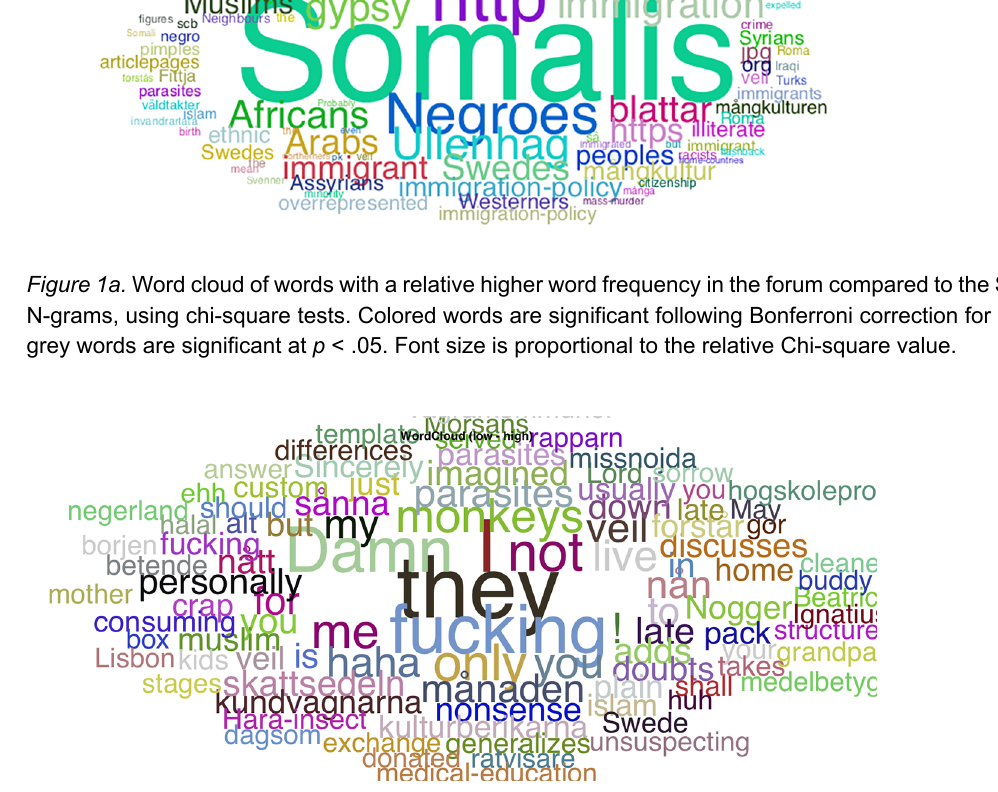
Correlation between LIWC dictionaries . Table 1 shows how the LIWC scores from different LIWC dictionaries correlate with each other. First, the pairwise correlation between all LIWC scores for each participant was